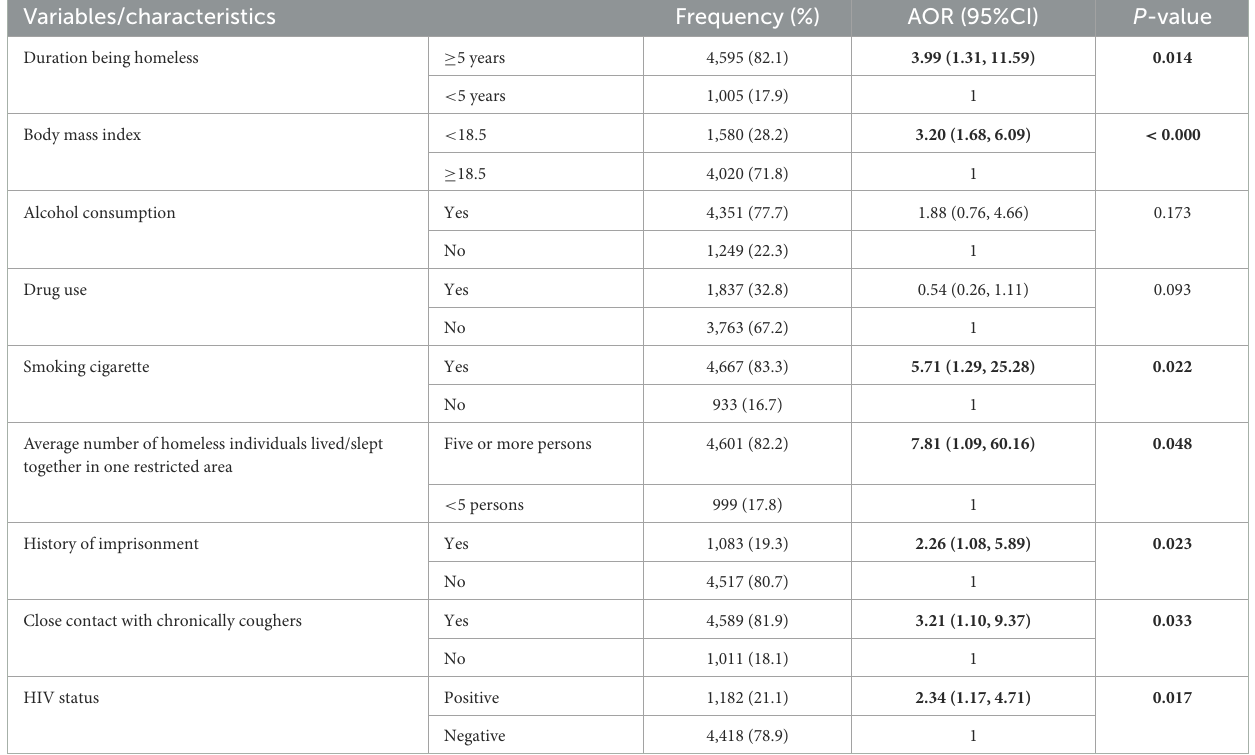
TABLE 2 Factors associated with bacteriological confirmed PTB among homeless individuals ( n = 5,600), Addis Ababa, Ethiopia, 2021.